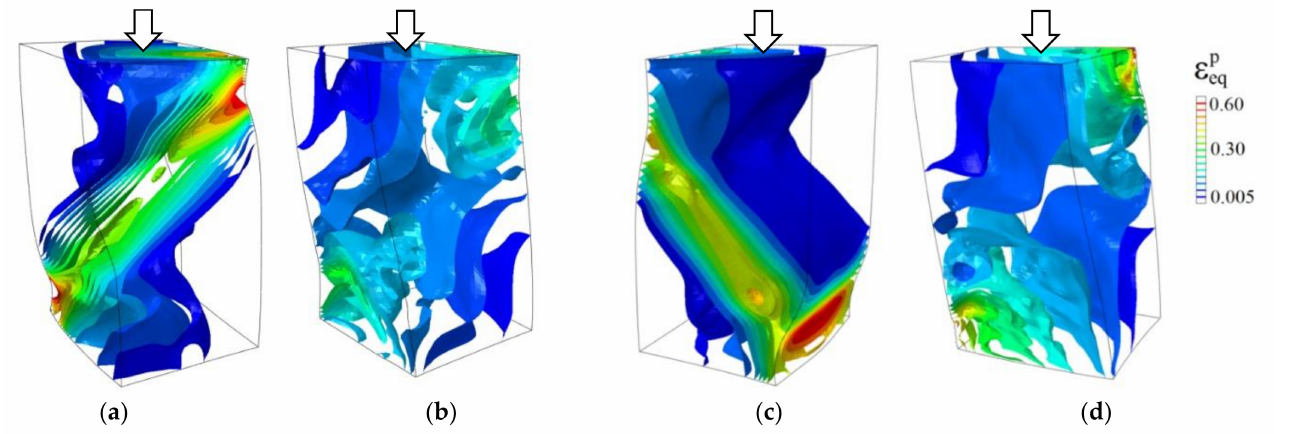
Figure 10. Isosurfaces of equivalent plastic strains in perfectly plastic ( a , c ) and strain-hardened single crystals ( b , d ) with the {100} ( a , b ) and {110} lateral faces ( c , d ) under compression along the [100] direction at a strain of